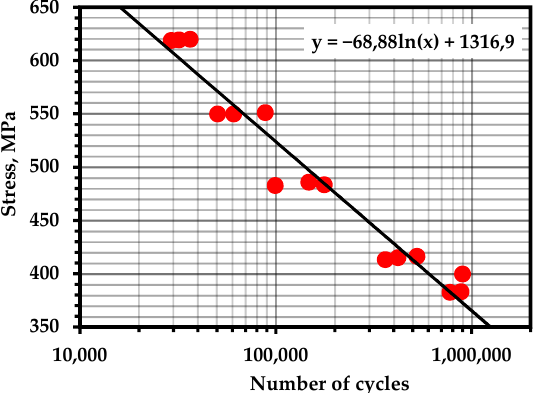
Figure A6. S–N Curve—Steel AISI 1080 (Temperature—293 K; frequency—30 Hz; R = − 1) [101].